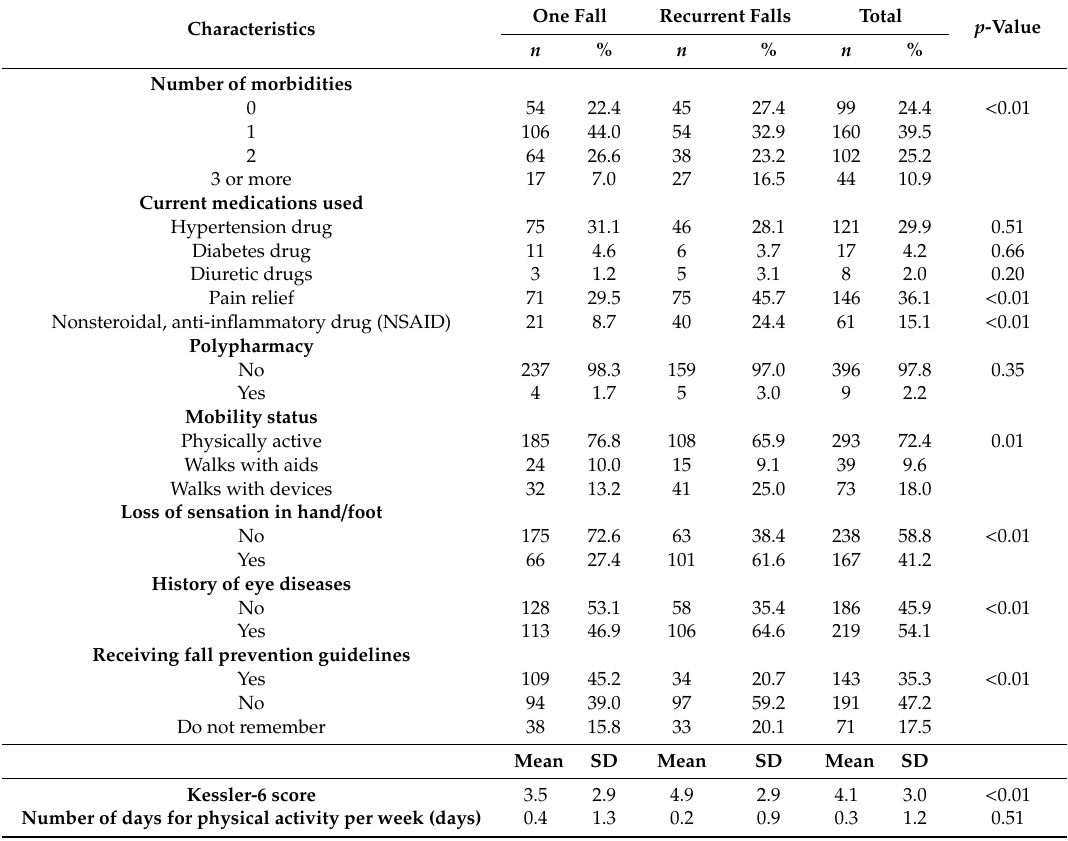
Table 2. Health and clinical characteristics of respondents.